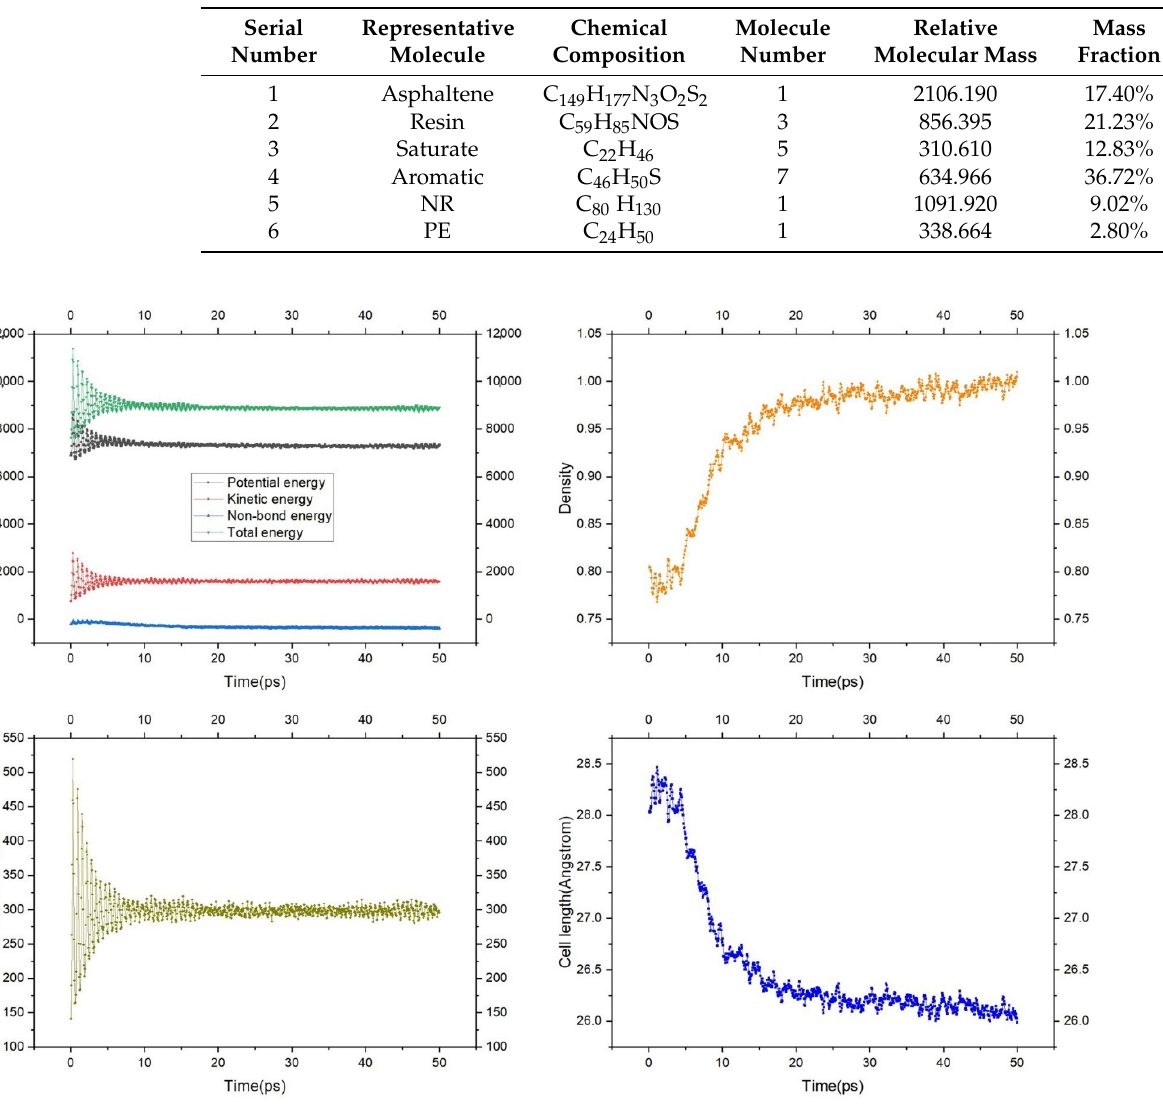
Table 3. PE/NR-modified asphalt model.